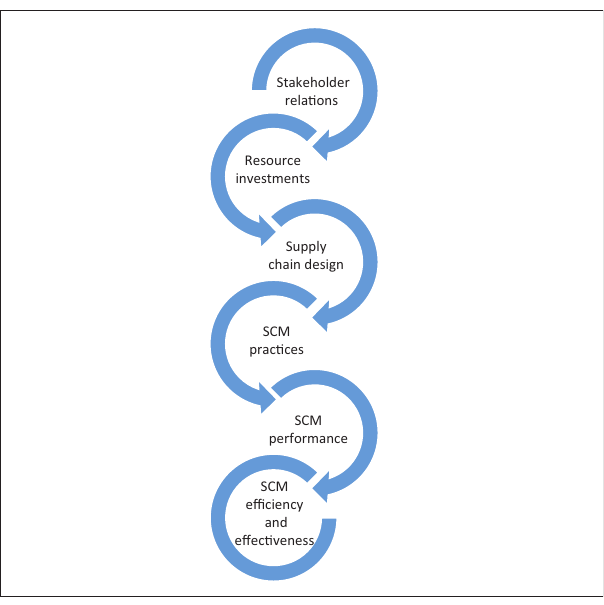
FIGURE 1: The performance model of supply chain